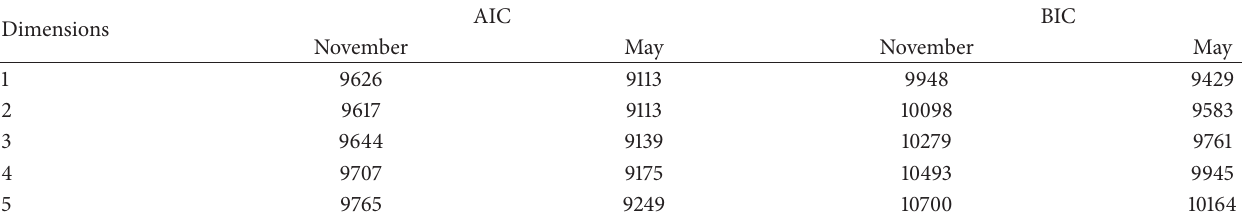
Table 10: Fit statistics for MIRT models with one to five dimensions, for November and May administration of the HCTA.